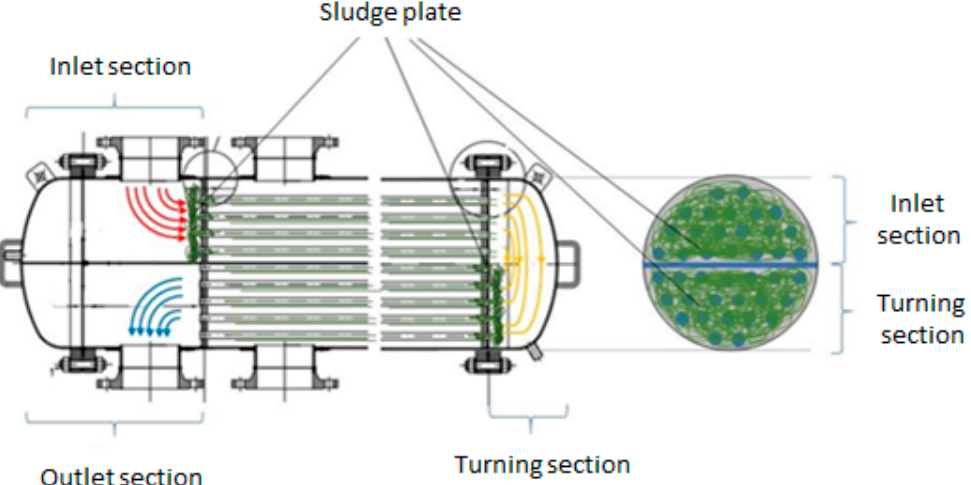
Figure 5. Schematics of the sewage heat exchanger.